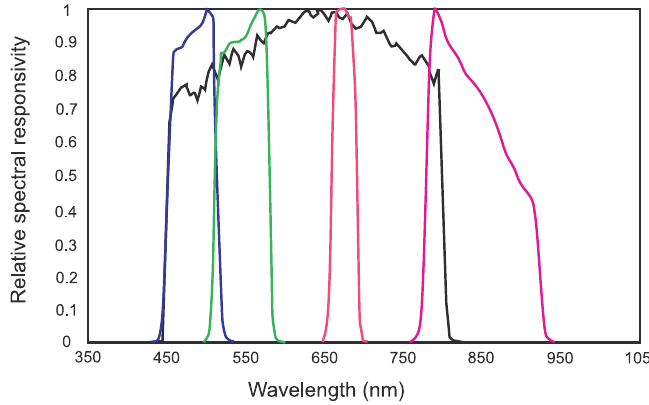
Figure 1. Spectral responsivity functions of GeoEye-1 (four-bands MS + Pan). Notice that the bandwidth of Pan encompasses part of the wavelengths of the rightmost NIR band and the red edge around 730